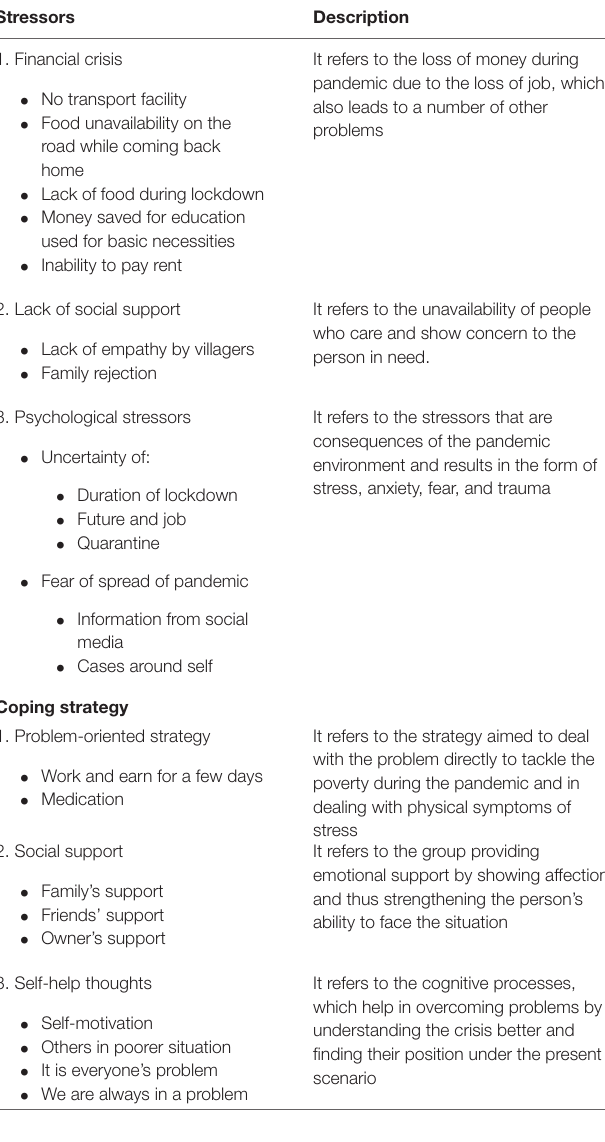
TABLE 2 | Major themes and subthemes that emerged from the interviews of migrant workers during lockdown due to COVID-19 pandemic.